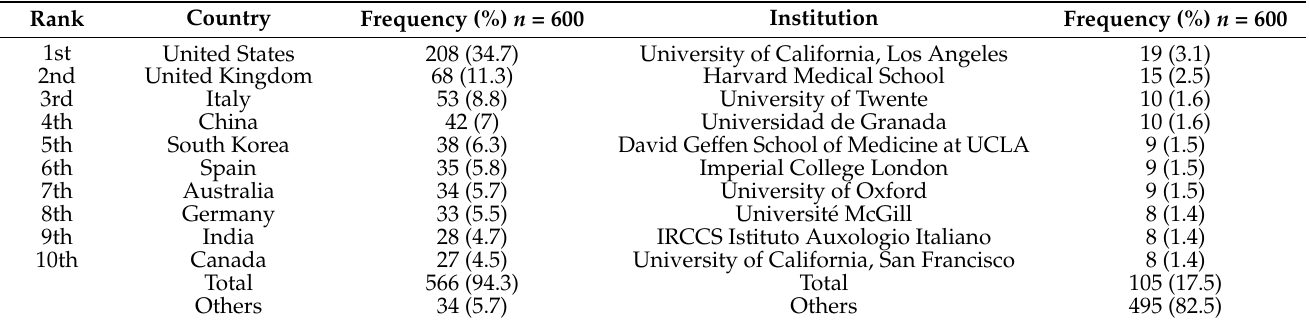
Table 3. Top 10 active countries and institutions on WTH research from 2000 to 2021 **.